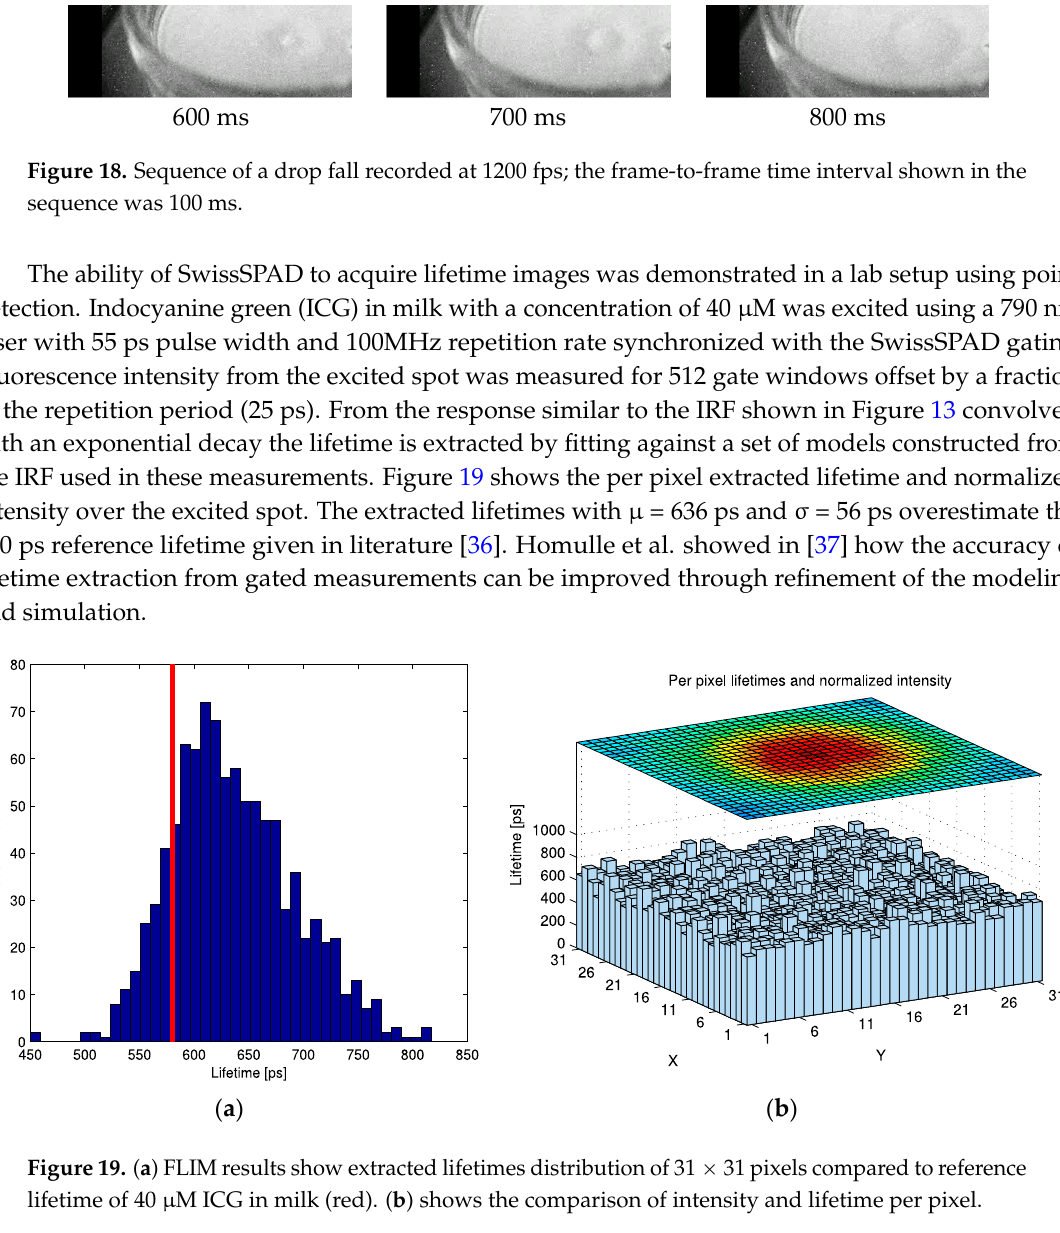
Table 1. Specifications of the sensor SwissSPAD. All the values are reported at room temperature.